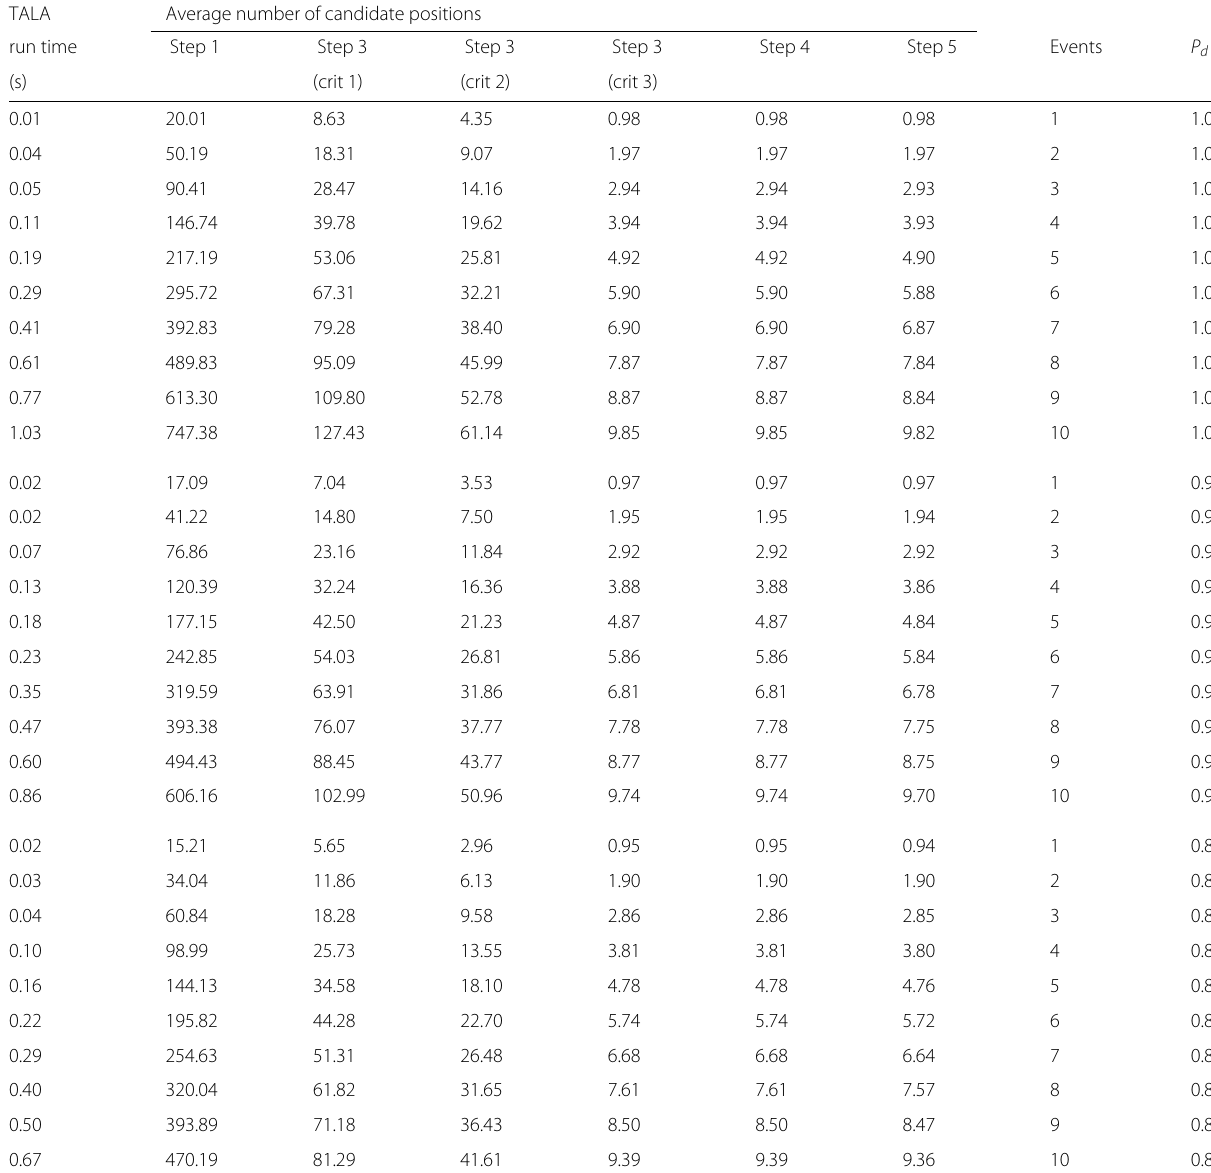
Table 4 TALA average computational time, and the average number of candidate locations at the end of each step of the TALA, for scenario